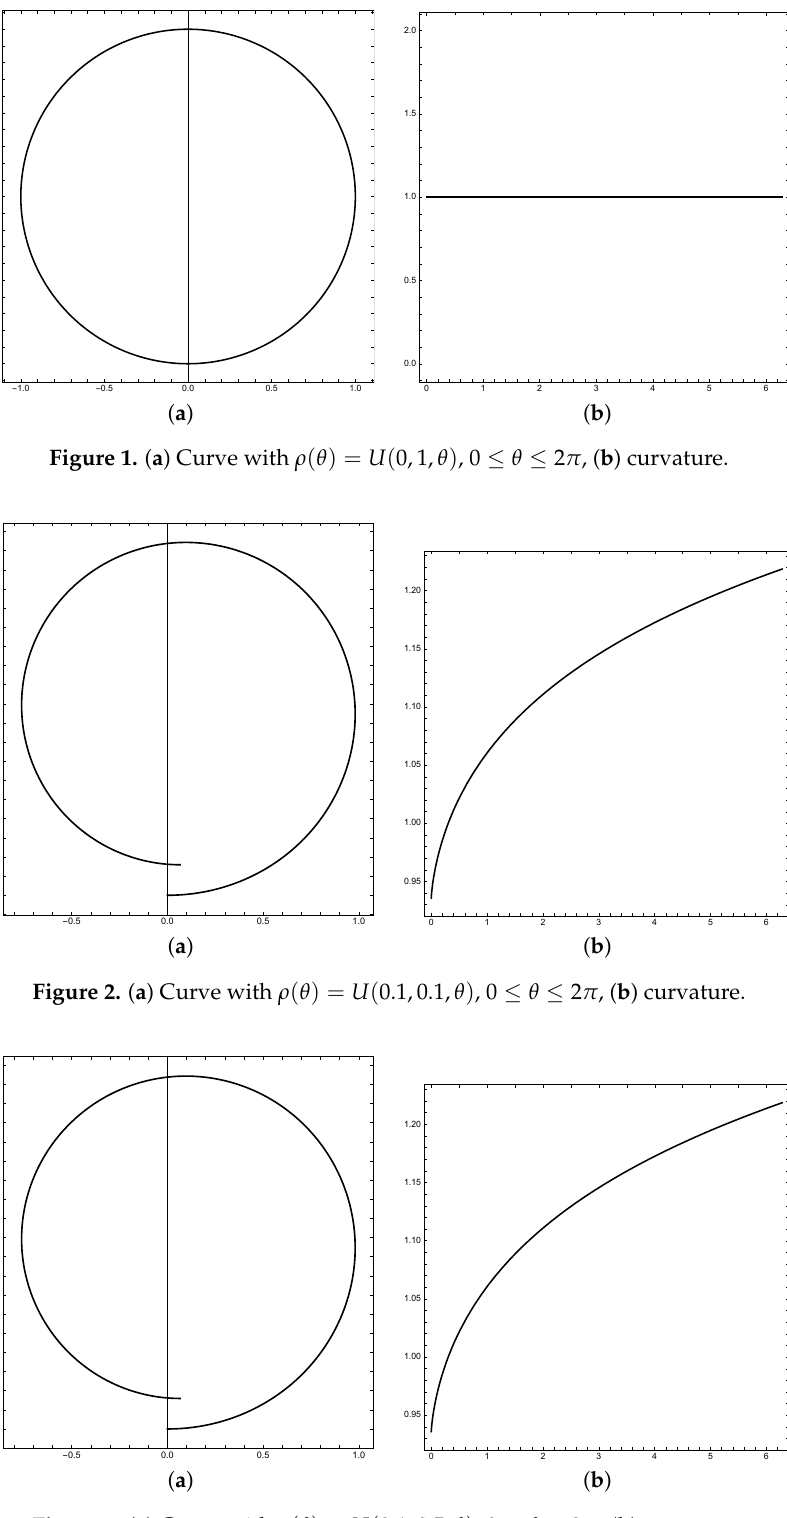
Figure 3. ( a ) Curve with ρ ( θ ) = U ( 0.1,0.5, θ ) , 0 ≤ θ ≤ 2 π , ( b )